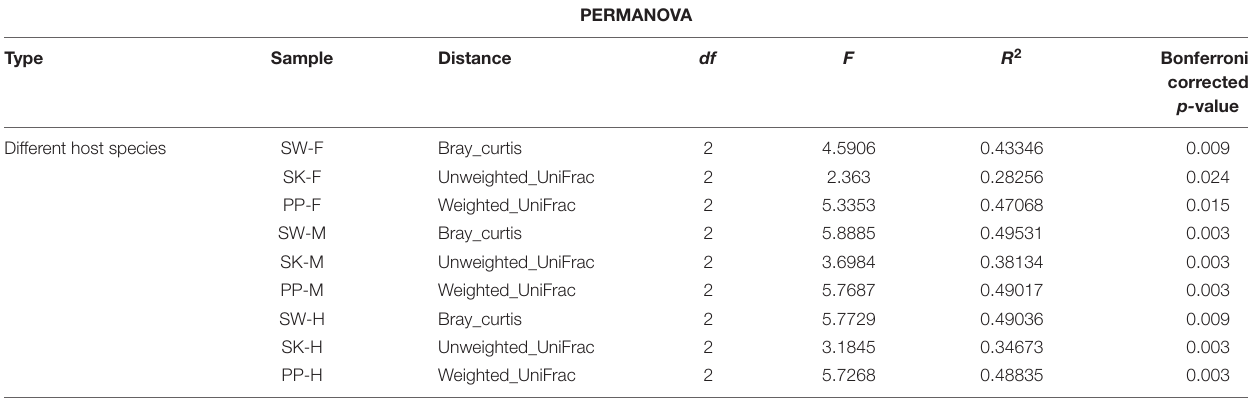
FIGURE 5 | Alpha and beta diversity of gut microbes of the three cold-water fishes. (A) The Chao 1 index was calculated for the foregut, midgut, and hindgut of SW, SK, and PP. (B) The phylogeny index was calculated for the foregut, midgut, and hindgut of SW, SK, and PP. In the box plot, the top line represents the upper quartile (75th percent), the bottom line represents the lower quartile (25th percent), and the line between the top and bottom lines represents the median. The black points represented the outliers. (C) Non-metric multidimensional scaling (NMDS) analysis based on Bray–Curtis distances to explore the dissimilarity in the gut microbes of the three cold-water fishes among different intestinal sections. From left to right: foregut, midgut, and hindgut. TABLE 2 | Results of the PERMANOVA for the gut samples of the three cold-water